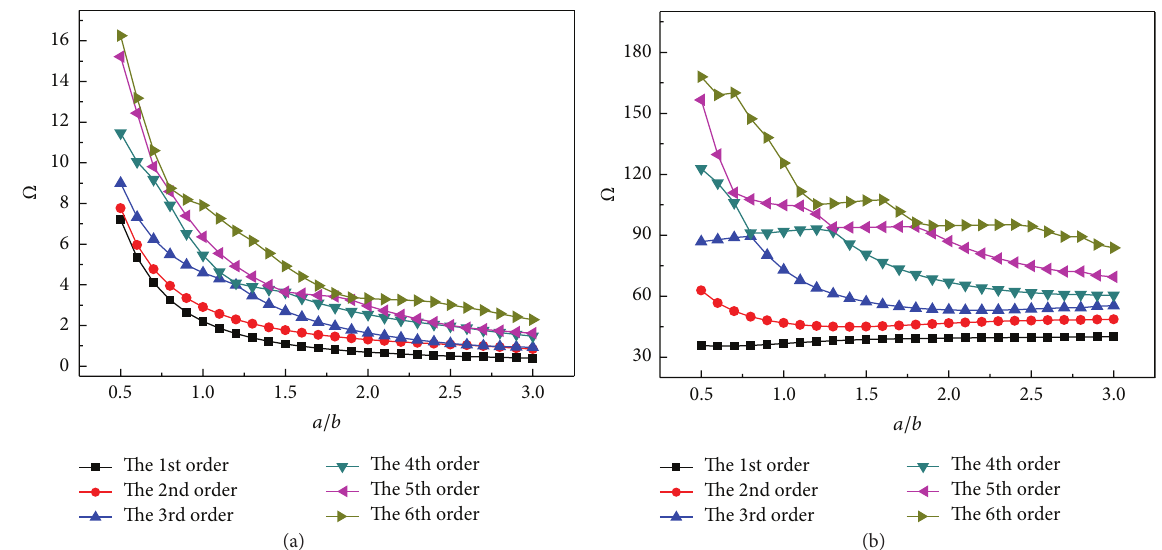
Figure 6: The effect of aspect ratio 𝑎/𝑏 on the natural frequencies Ω for S-S-S-S boundary condition: (a) uniform thickness and (b) nonuni- form